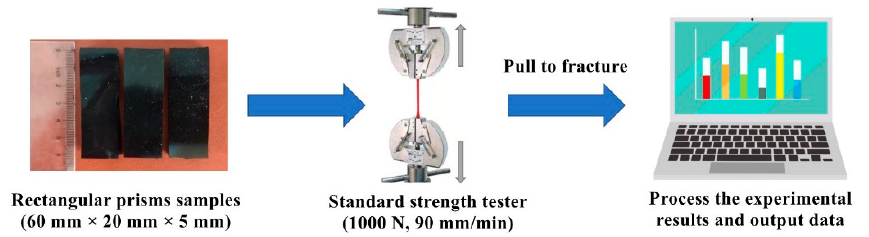
Figure 2. Schematic illustration of tensile test.